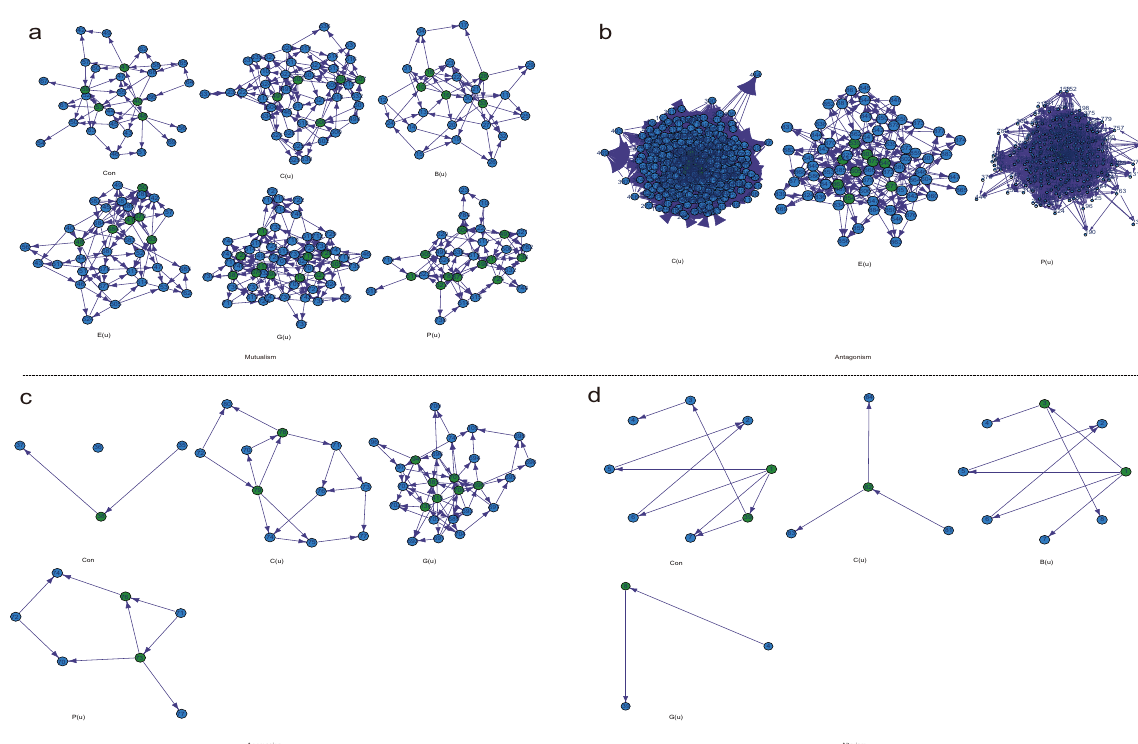
Fig. 4 Bayesian QTL networks of signi fi cant SNPs mediating interaction networks of microbial network. a mutualism. b antagonism. c aggression. d altruism. Hub QTLs within each genetic network are highlighted in green circles. The emergent properties of each microbial network are described by connectivity (Con), closeness (C(u)), betweenness (B(u)), eccentricity (E(u)), eigencentrality (G(u)), and PageRank